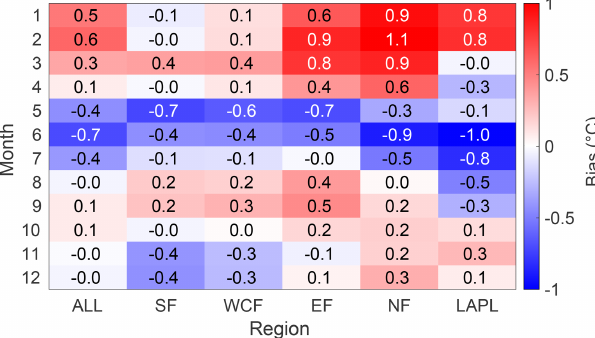
Figure 4. The monthly mean biases of simulated near-surface air temperature averaged over Southern Finland (SF), Western and Central Finland (WCF), Eastern Finland (EF), Northern Finland (NF), Lapland (LAPL), and the whole of Finland (ALL) in 2002– 2014 with a reference to